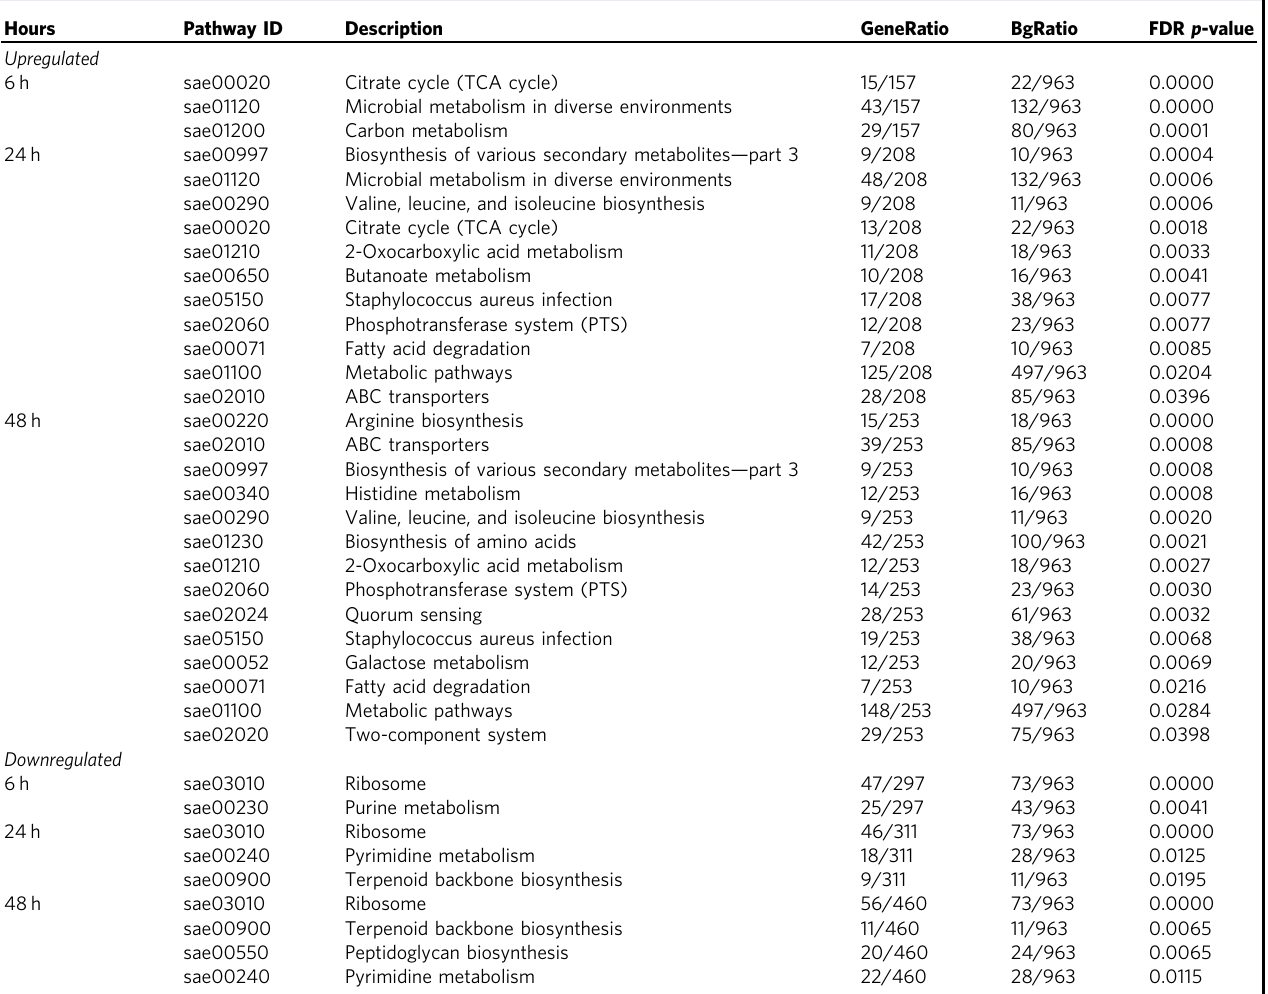
Table 1 KEGG pathway enrichment analysis for upregulated and downregulated genes of S. aureus -infected liver compared with culture